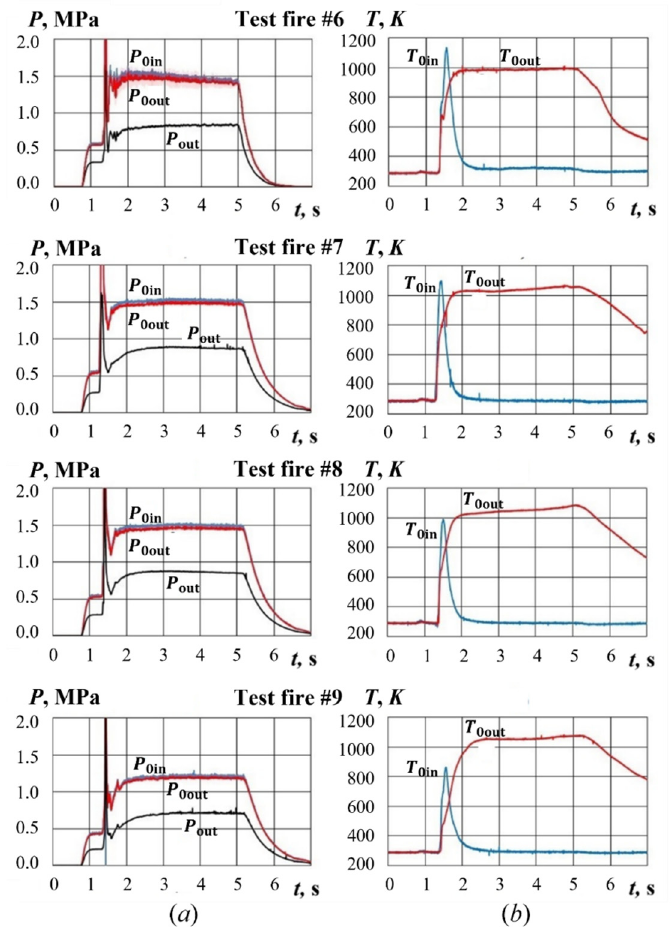
Figure 11. Time histories of ( a ) pressure and ( b ) temperature at PP sample inlet and outlet in test fires #6 to #9.